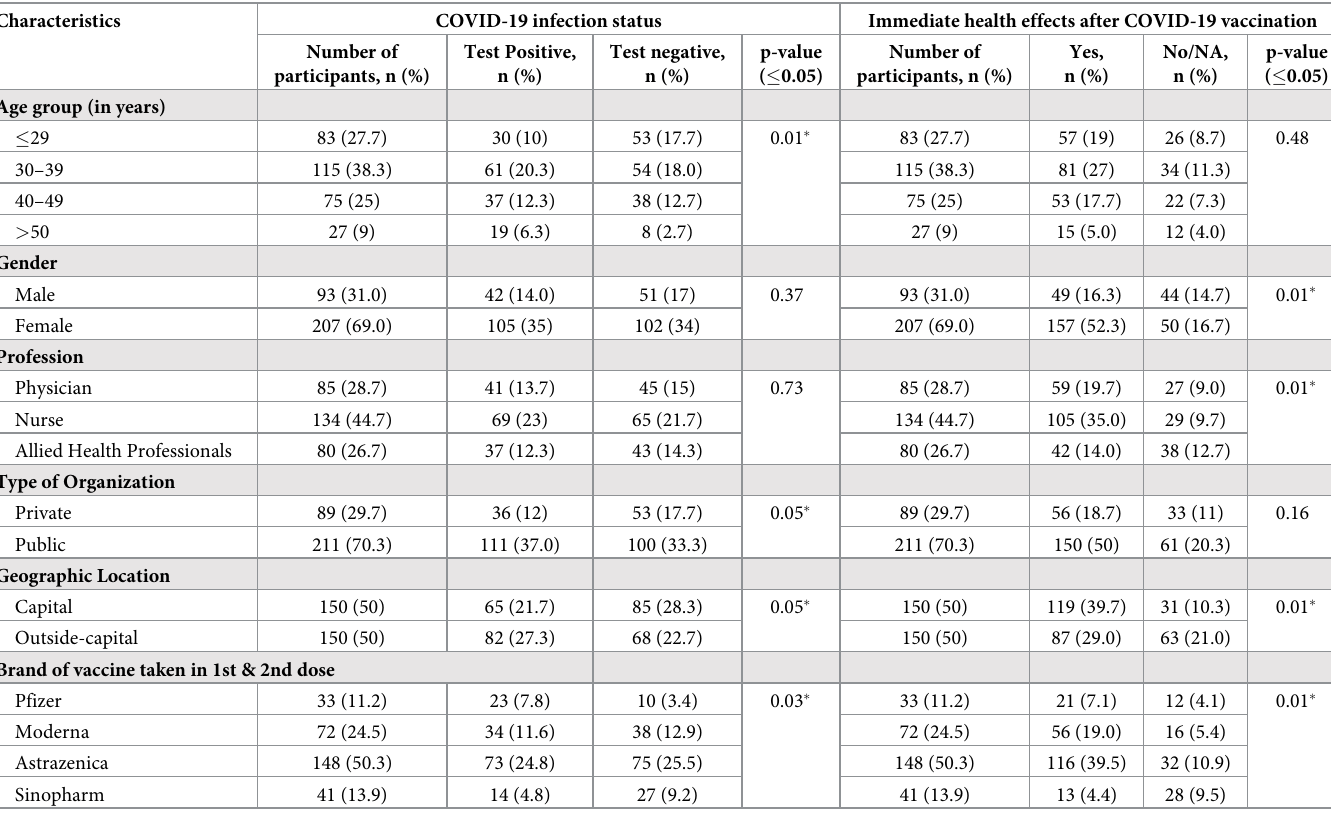
Table 1. Characteristics of the respondents according to COVID-19 infection status and immediate health effects after vaccination (n = 300).